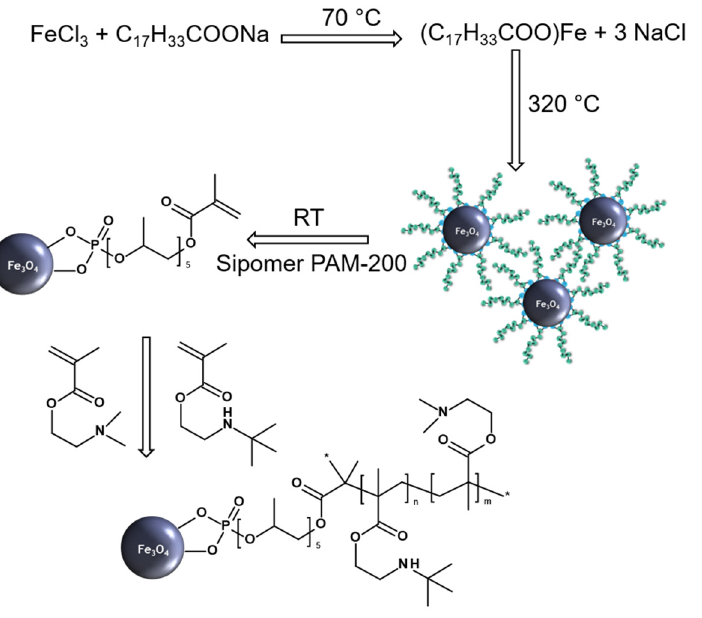
Figure 1. Synthesis of Fe 3 O 4 nanoparticles, their modification with Sipomer PAM-200 and poly[2-(dimethylamino)ethyl methacrylate] or poly[2-(dimethylamino)ethyl methacrylate- co -2-( tert -butylamino)ethyl methacrylate].